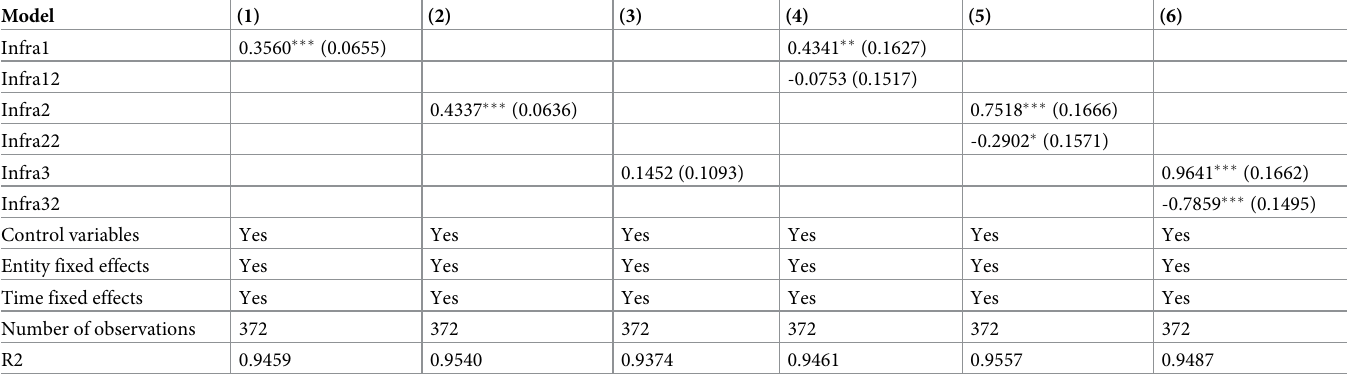
Table 6. Impact of different types of infrastructure on tourism industry